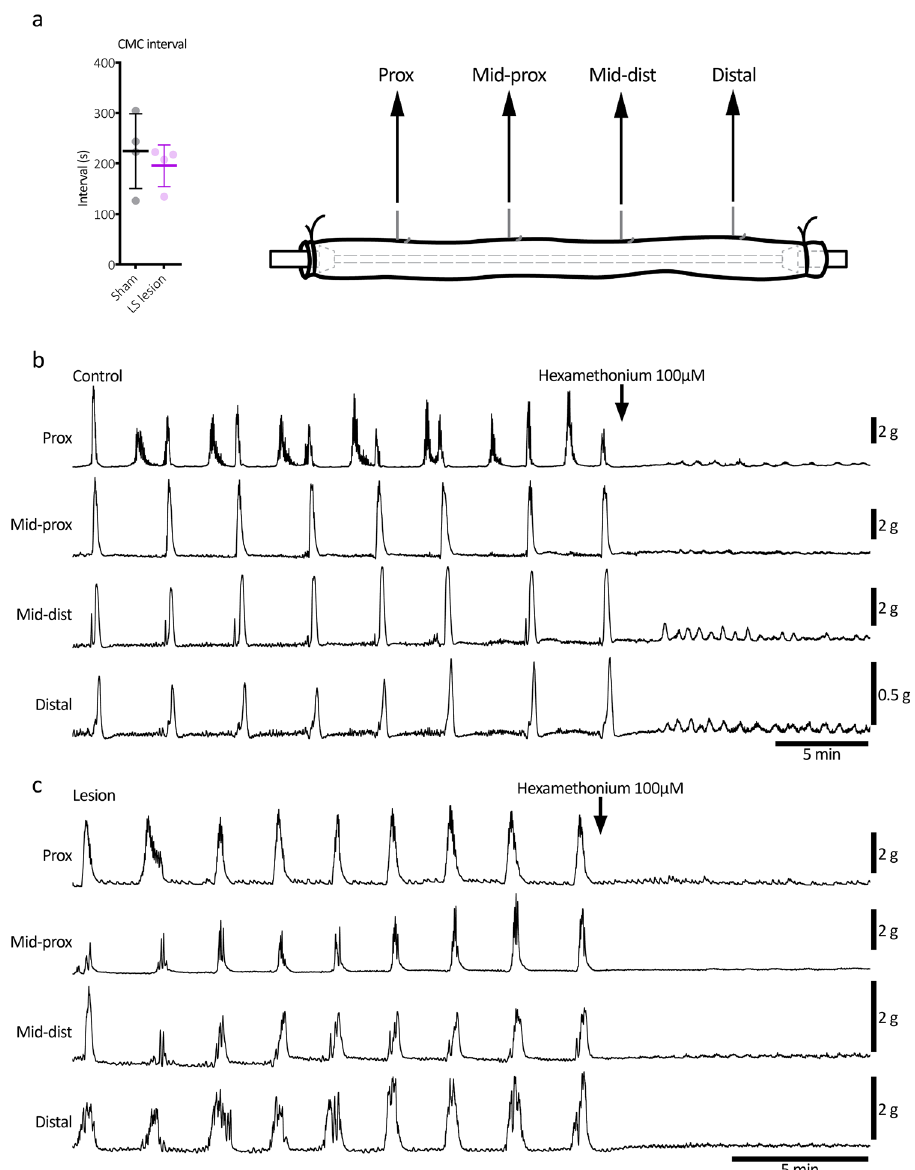
Fig. 10 Ex vivo colonic motility after lumbosacral DRG lesion. a The removal of L5-S1 DRG had no signi fi cant effect on the frequency of the colonic motor complex ex vivo (mean intervals: 225 ± 74 vs. 196 ± 41 s, control vs. LS lesion, respectively; P = 0.522, t = 0.680, DF = 6; independent samples 2 tailed t test, N = 4 in each group). Error bars represent mean ± SD, individual markers represent individual animal averages. b , c Representative mechanical recordings from control and LS lesioned mice, respectively. Hexamethonium promptly abolished high amplitude contractions in both examples, con fi rming their dependence on nicotinic transmission within the enteric nervous distal colon (Fig. 10). A fi ne suture thread connected each hook to an iso- metric force transducer (Grass FT-03C; Grass, Quincy, MA, USA), which was set to a basal tension of 0.5 g to record ongoing mechanical activity for 60 min at 1 kHz sampling rate (PowerLab 16/35, LabChart 8, ADInstruments, NSW, Australia).